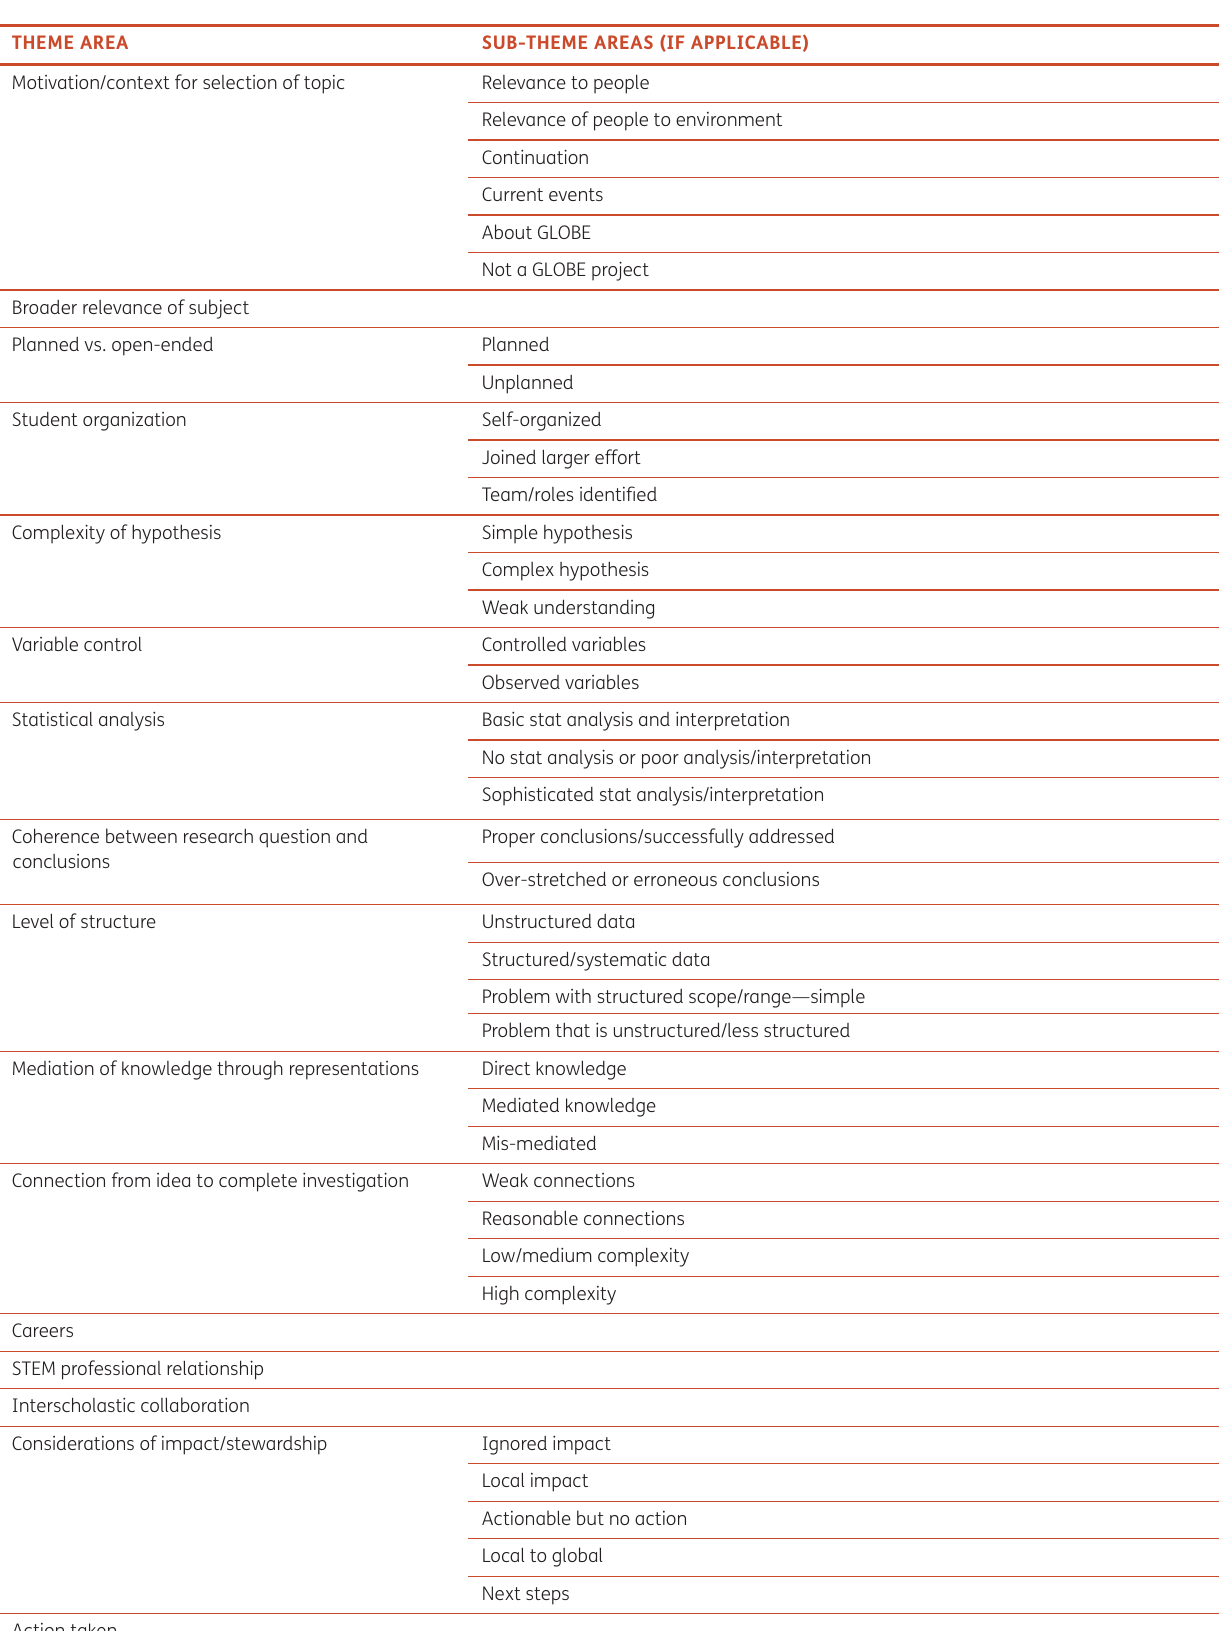
Table 3 Summary of theme and sub-theme areas of final code